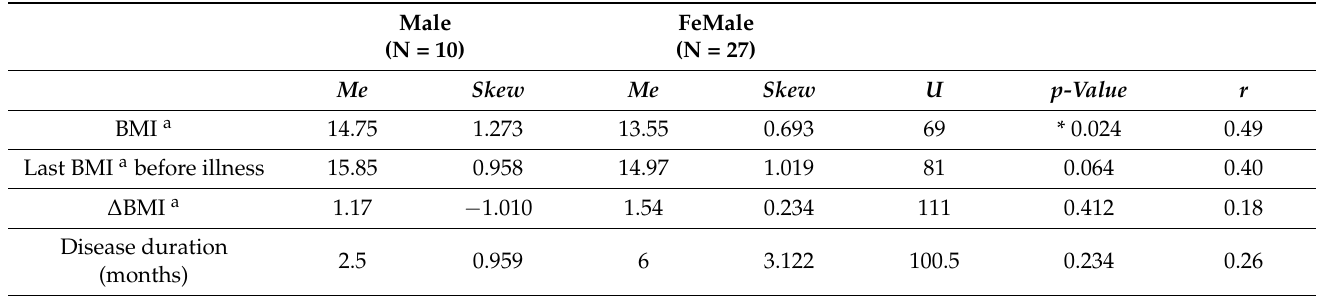
Table 1. Clinical features of Middle childhood Participants at admission.